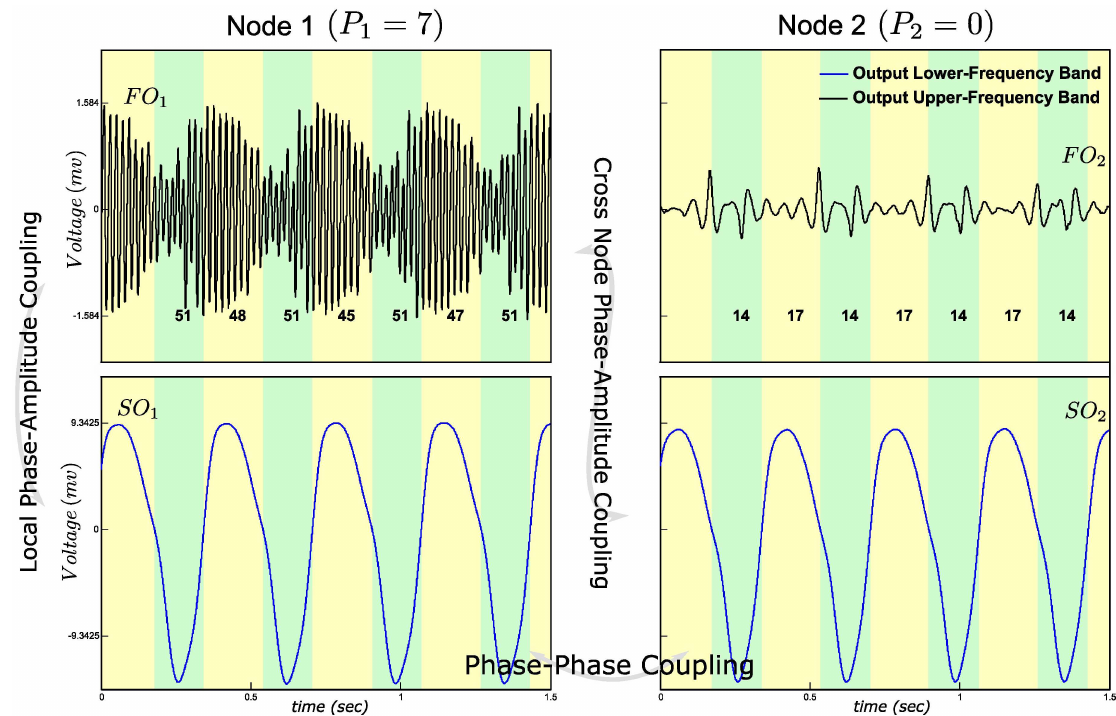
Fig 3. Phase-Amplitude Coupling (PAC) simulation. The instantaneous amplitudeof FO 1 correlates with the synchronized SO 1 and SO 2 . Local PAC betweenFO 1 and SO 1 and cross-node PAC betweenFO 1 and SO 2 are observable. Integers belowthe FO time waves indicate averagenumber of zero crossingsof FOs.